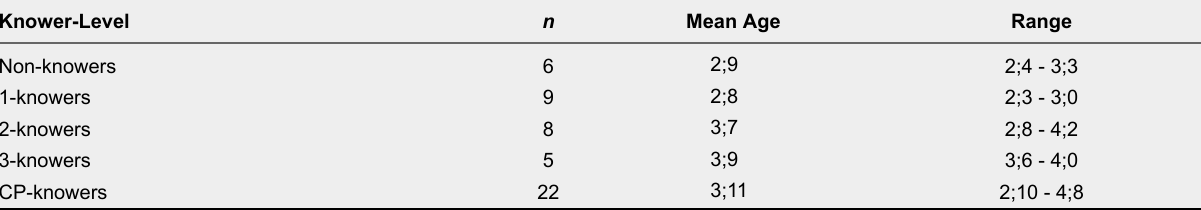
Age and Number of Children in Each Knower-Level Group in Experiment